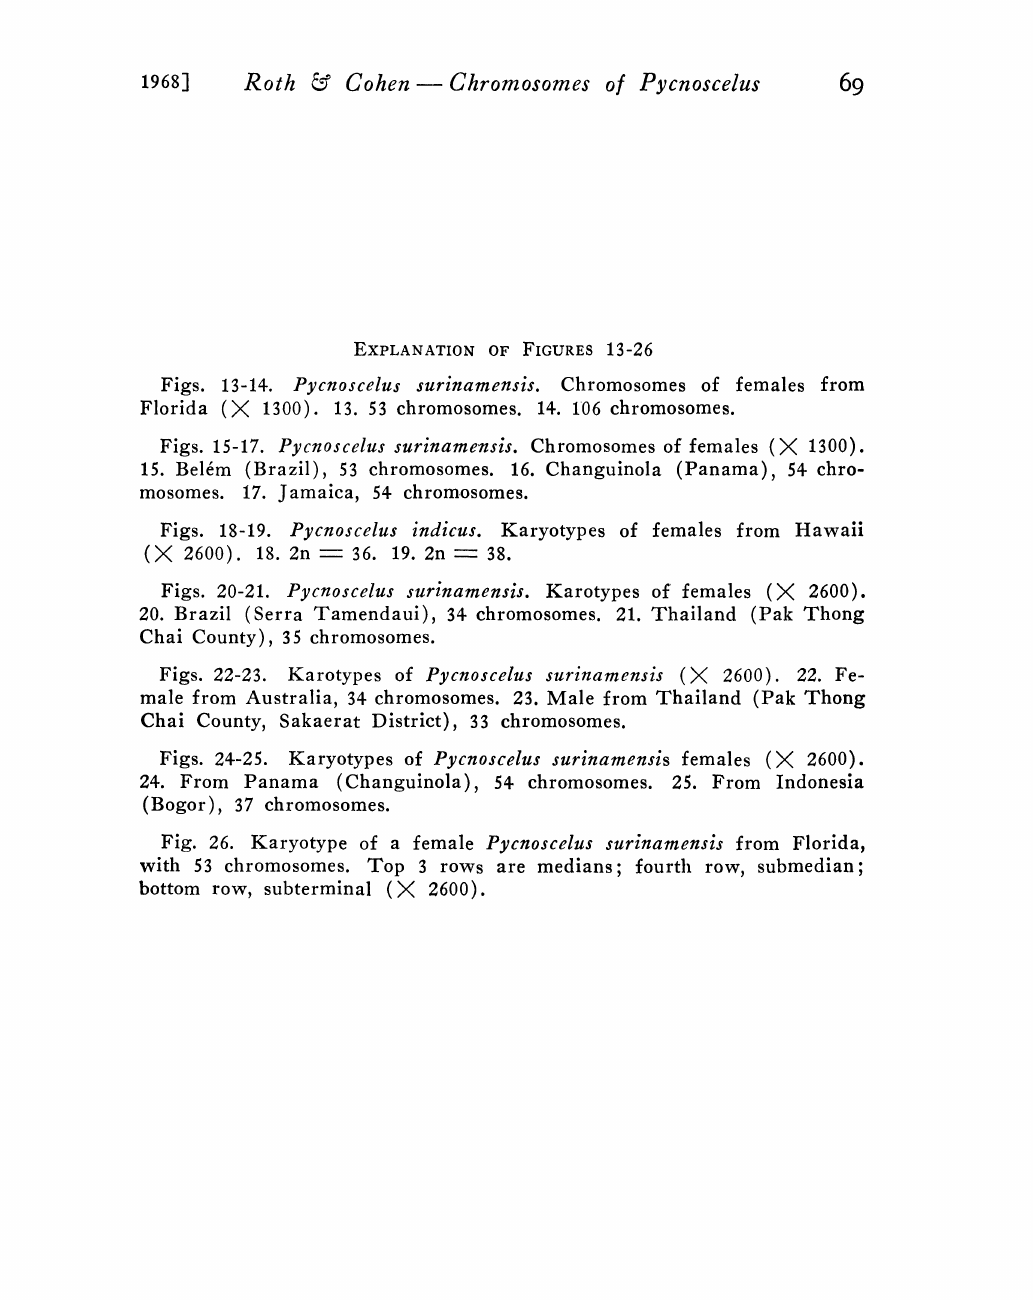
Figs. 13-14. Pycnoscelus surinamensis. Chromosomes of females from Florida (X 1300). 13. 53 chromosomes. 14. 106 chromosomes. Figs. 15-17. Pycnoscelus surinamensis. Chromosomes of females (X 1300). 15. Bel6m (Brazil), 53 chromosomes. 16. Changuinola (Panama), 54 chro- mosomes. 17. Jamaica, 54 chromosomes. Figs. 18-19. Pycnoscelus indicus. Karyotypes of females from Hawaii (X 2600). 18. 2n 36. 19. 2n 38. Figs. 20-21. Pycnoscelus surinamensis. Karotypes of females (X 2600). 20. Brazil (Serra Tamendaui), 34 chromosomes. 21. Thailand (Pak Thong Chai County), 35 chromosomes. Figs. 22-23. Karotypes of Pycnoscelus surinamensis (X 2600). 22. Fe- male from Australia, 34 chromosomes. 23. Male from Thailand (Pak Thong Chai County, Sakaerat District), 33 chromosomes. Figs. 24-25. Karyotypes of Pycnoscelus surinamensis females (X 2600). 24. From Panama (Changuinola), 54 chromosomes. 25. From Indonesia (Bogor), 37 chromosomes. Fig. 26. Karyotype of a female Pycnoscelus surinamensis from Florida, with 53 chromosomes. Top rows are medians; fourth row, submedian; bottom row, subterminal (X